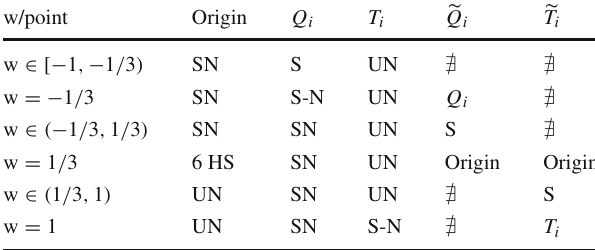
Table 1 Topological type of each equilibrium point of system (20) for − 1 ≤ w ≤ 1 w/point